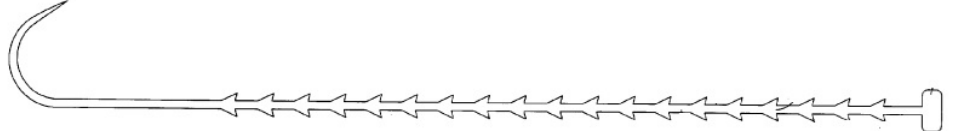
Figure 7. Morency and Jones’ barbed suture, fabricated from a flat sheet with the barbs cut along the lateral edges [11].